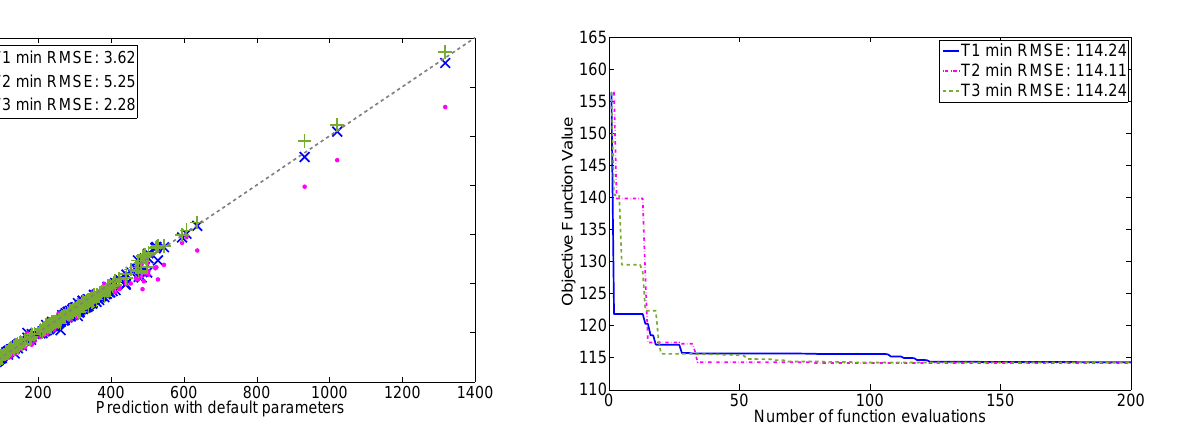
Figure 4. Progress plot that shows the development of the best ob- jective function value found vs. the number of function evaluations for the real data case with d = 5 parameters for optimization tri- als T1, T2, and T3. The legend shows the lowest RMSE value found in each trial. The first function evaluation (left side of the graphs) corresponds to the RMSE when using the default